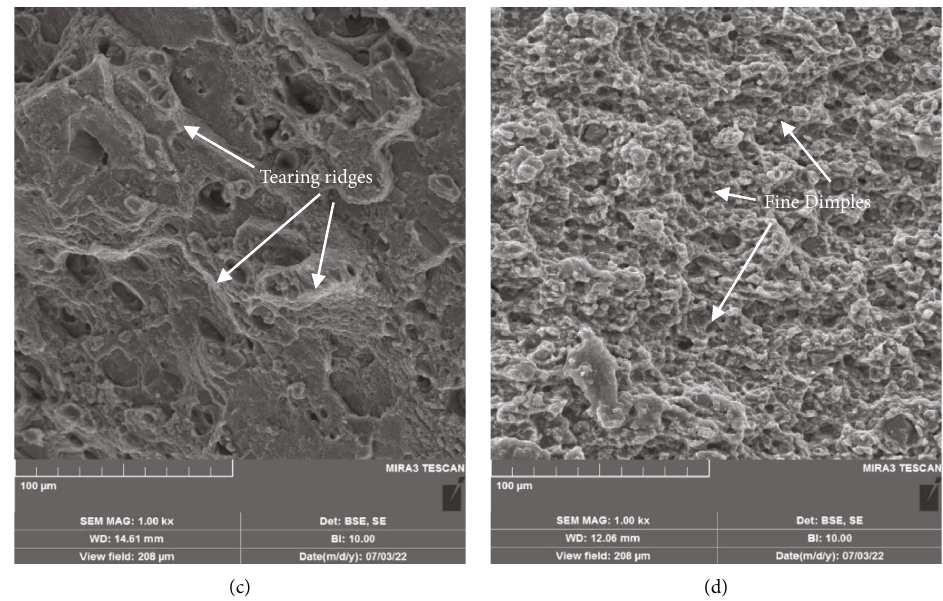
Figure 11: SEM morphology pictures of the fracture surface of tensile test joints. DS-FSW at (a) 36 mm/min and (b) 102mm/min. SS-FSW at (c) 36mm/min and (d)